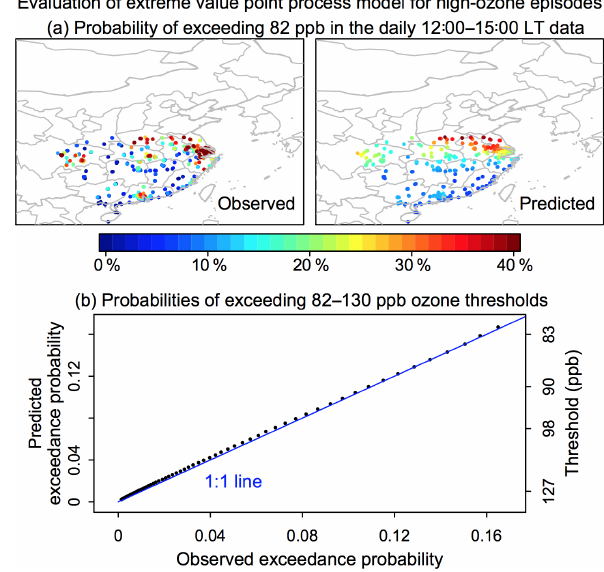
Figure 5. Evaluation of the extreme value point process (PP) model for predicting the probability of occurrence of summertime high- ozone episodes from the OMI daily data. The episodes are defined by exceedance of a given ozone threshold in the 3h average data at 12:00–15:00 local time. (a) Observed and predicted probability of ozone episode days exceeding a 82ppb threshold. The predicted probability is calculated from Eq. (8). (b) Observed and predicted probabilities of exceeding higher thresholds from 82 to